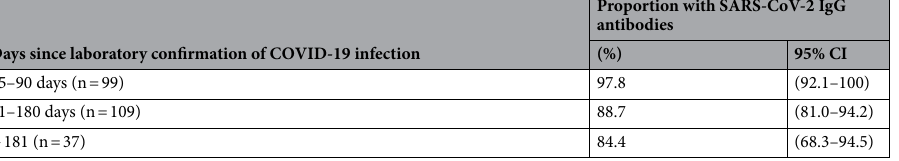
Table 3. Proportion of non-vaccinated participants previously diagnosed with COVID-19 with detectable antibodies against SARS-CoV-2 divided by the number of days after diagnosis. Sweden April 26–May 9, 2021 (n =